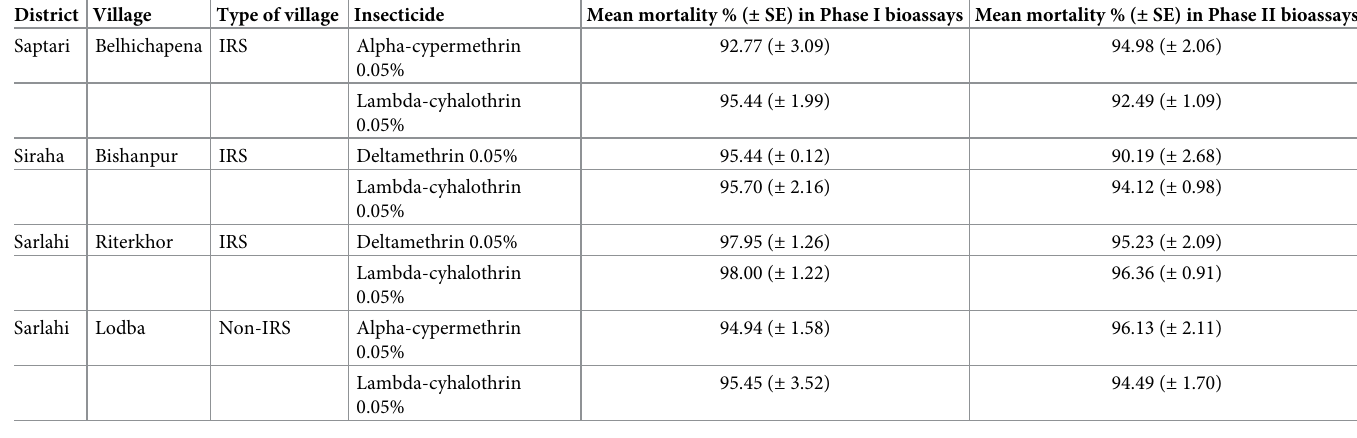
Table 3. Assessment of mean mortality percentage of P . argentipes to discriminating concentrations of pyrethroids in bioassays in selected villages with possible resistant vector populations detected in Phase I. District Village Type of village Insecticide Saptari Belhichapena